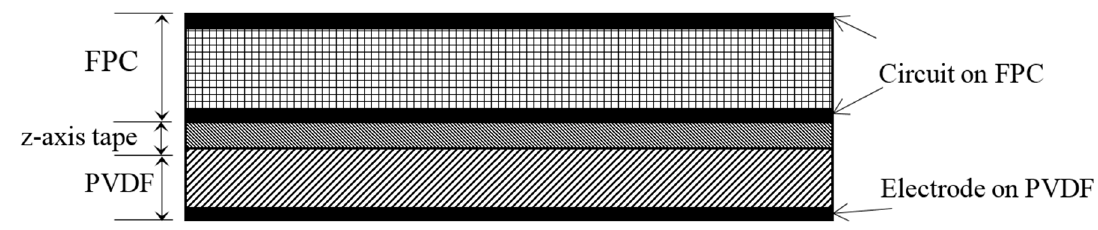
Figure 7. Cross-section of the 3-layer sensor structure.